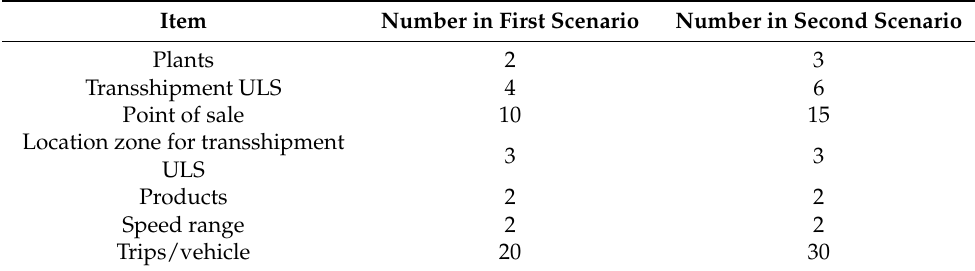
Table 2. Description of benchmark instances.